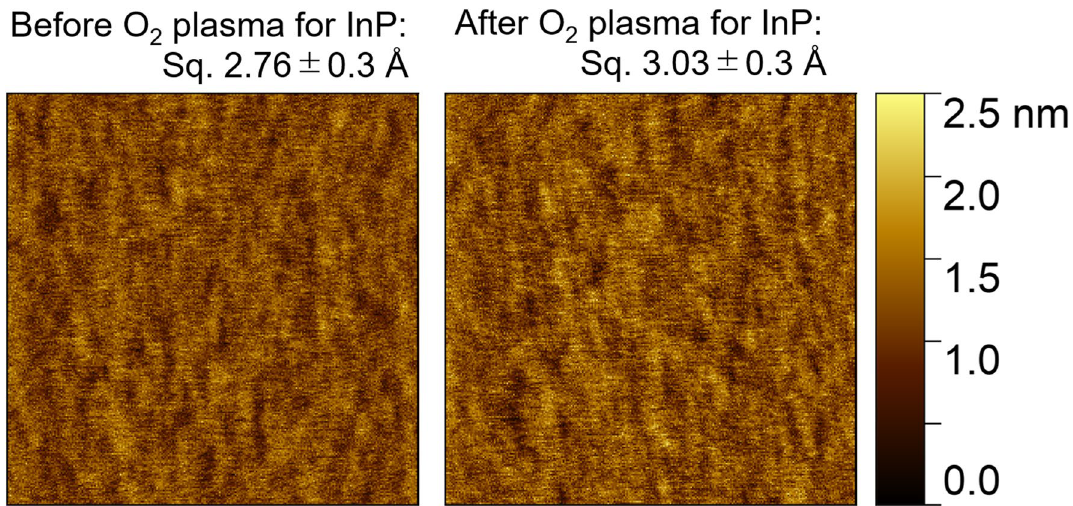
Figure 3. AFM surface image of InP substrate before and after the oxygen plasma irradiation. The activated surface was sufficiently smooth for bonding